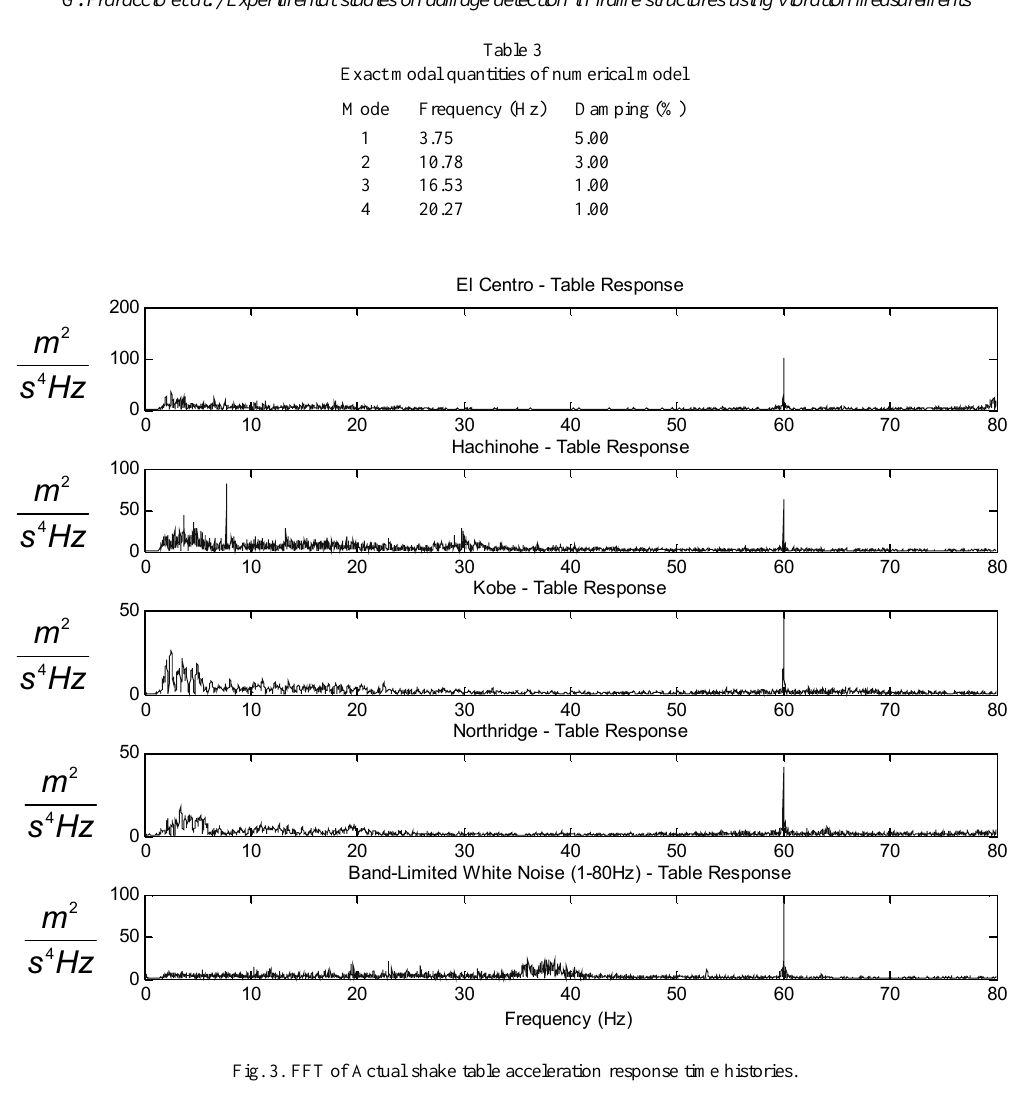
Fig. 3. FFT of Actual shake table acceleration response time